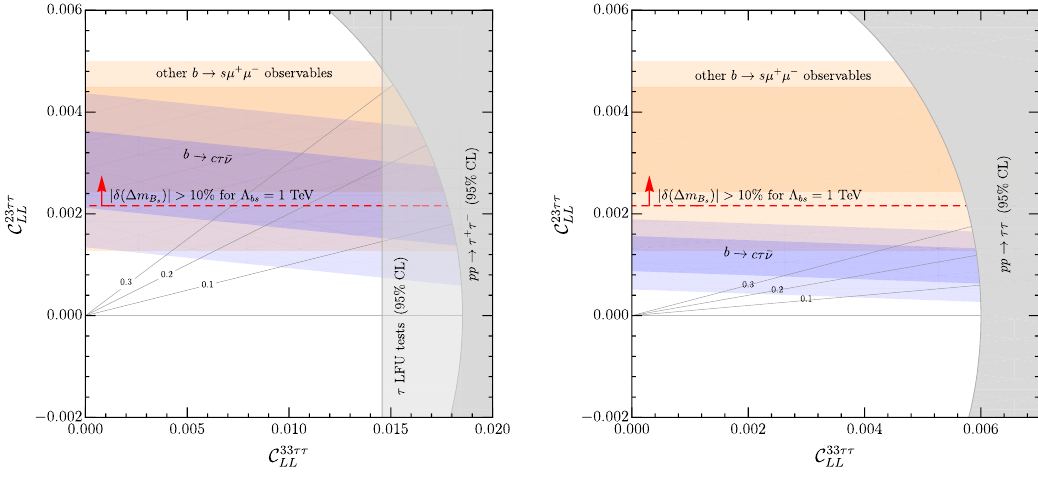
and C 23 ττ in the two benchmark scenarios Figure 3 . Combined analysis of the coefficients C 33 ττ LL LL defined by C i 3 ττ = 0 (left panel) and C i 3 ττ = −C i 3 ττ (right panel). The blue bands denote the 1 σ LR LR LL and 2 σ regions preferred by b → cτ ¯ ν data, while the gray bands show the exclusion regions derived from σ ( pp → τ + τ − + X ) . The preferred values of C 23 ττ derived from b → sµ + µ − data (at 1 σ LL and 2 σ ) are indicated by the horizontal orange bands. The dashed red lines provide a qualitative indication of the bound from B - ¯ B mixing (see text for more details). The gray lines indicate s s reference values of the ratio C 23 ττ / C 33 ττ ∼ (cid:15) q LL LL